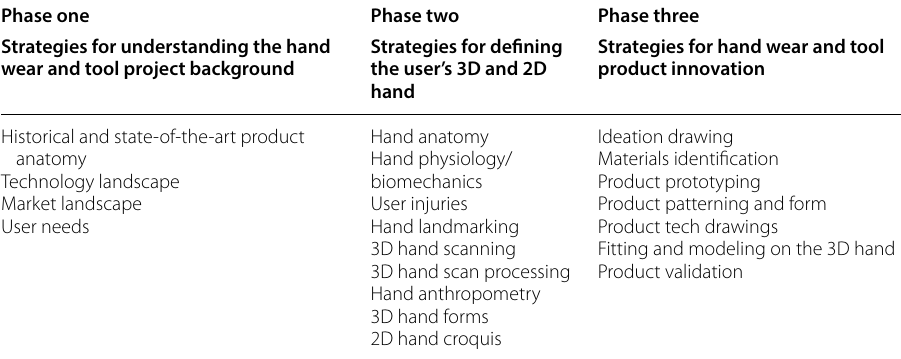
Table 1 Performance hand wear and tools product innovation framework Phase